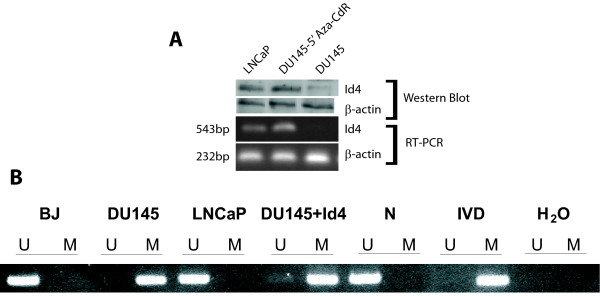
(A) Id4 expression is generally absent in DU145 cells but present in androgen receptor positive LNCaP cells. Treatment of DU145 cells with global de-methylation agent 5'-Aza-2-Deoxycytidine (5-AZA-CdR) leads to Id4 expression as determined by western blot analysis (upper panel) and reverse transcriptase polymerase chain reaction (RT-PCR, lower panel). Beta-actin was used as a loading and RT-PCR control. The primer pairs used for amplification were described in [43]. (B) Analysis of Id4 methylation in human fibroblasts (BJ) and the prostate cancer cell lines DU145, DU145-Id4 (DU145 cells with constitutively expressed Id4) and LNCaP by methylation specific PCR (MSP). The presence of a PCR band in lanes marked "M" indicates a methylated gene sequence, the presence of a PCR band in lanes marked "U" indicates an un-methylated gene sequence. Normal peripheral blood cells (N), in vitro methylated DNA (IVD) and water served as controls.